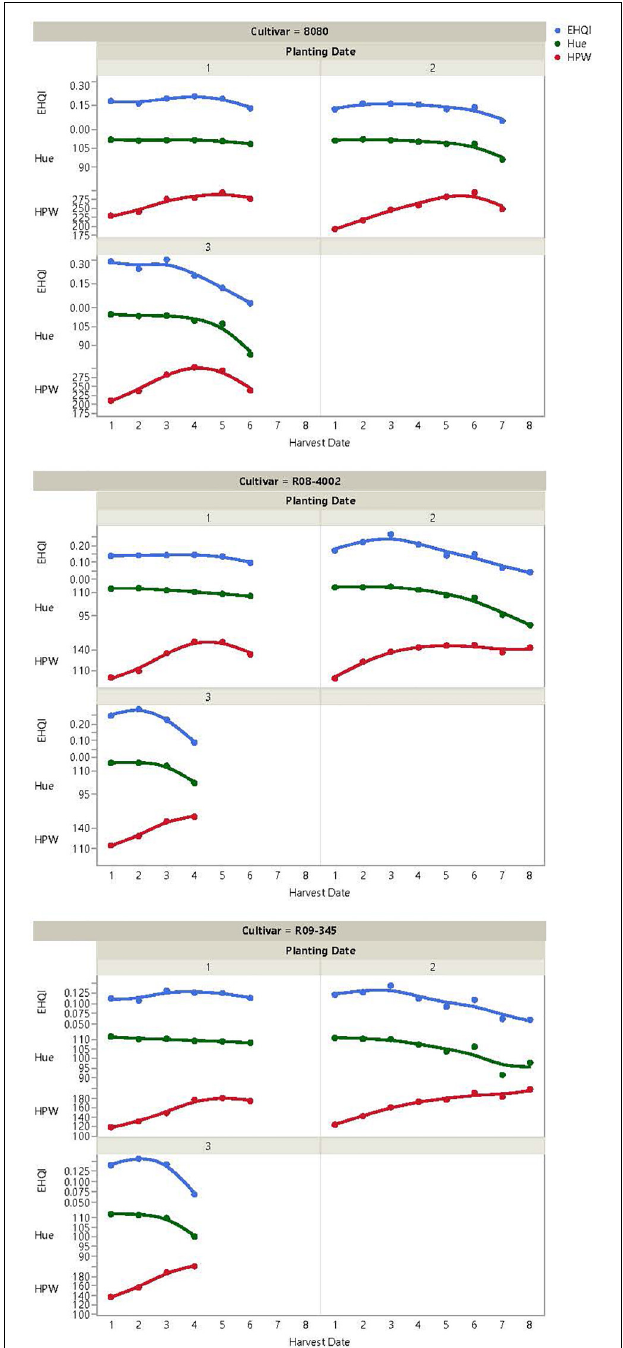
FIGURE 1 | Edamame Harvest Quality Index (EHQI), Hue, and Hundred-Pod Weight (HPW) of three soybean cultivars when planted in three planting dates and subjected to weekly harvest dates, beginning at R5.8 stage and discontinuing at R7 physiological stage.